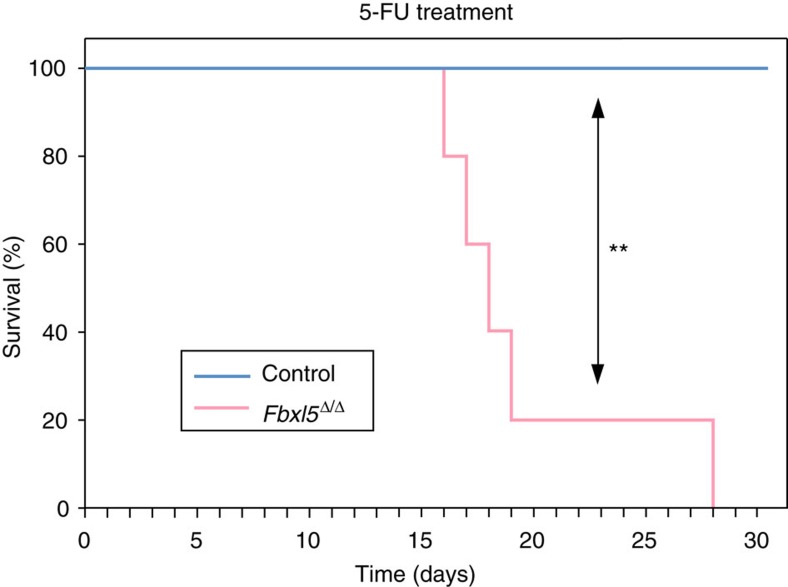
Cellular iron overload impairs stress-induced hematopoiesis.The survival rate of Fbxl5Δ/Δ or control mice (n=5) injected with 5-FU (150 mg kg−1) at 10-day intervals beginning on day 0 at 20 weeks after the last poly(I:C) injection was determined. **P<0.01 (log-rank test).